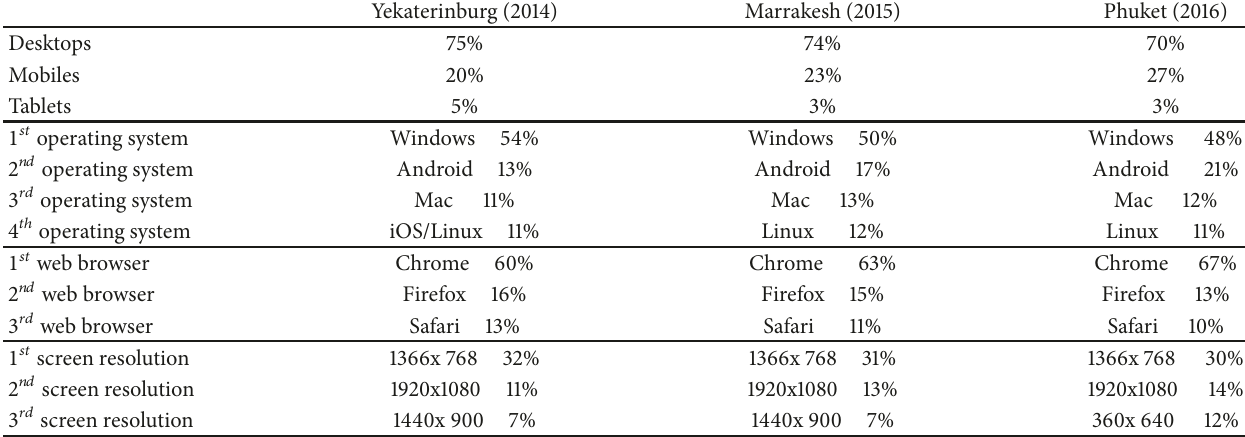
Table 2: World Finals 2014-16 total audience details (TOTAL).